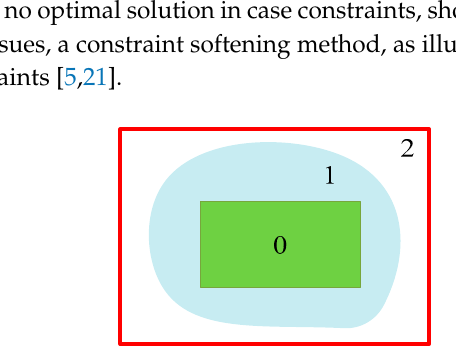
Figure 5. Sketch of system IO constraints. 0—steady driving zone, 1—computing feasible sets, and 2—collision boundary.